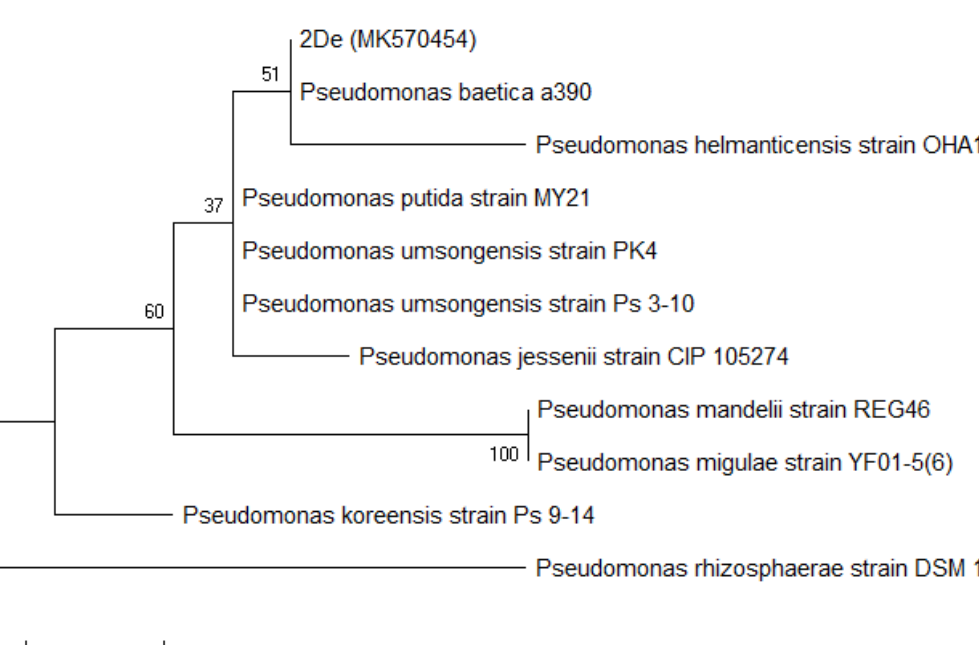
Figure 1. Maximum likelihood-based phylogeny derived from 16S rRNA sequence data, representing the relative position of the 2De strain among other Pseudomonas . All positions containing gaps or missing data were deleted. Bootstrap values are represented at the branching points. The bar represents 0.002 substitutions per site, accession number from GenBank for 2De strain is shown in brackets.